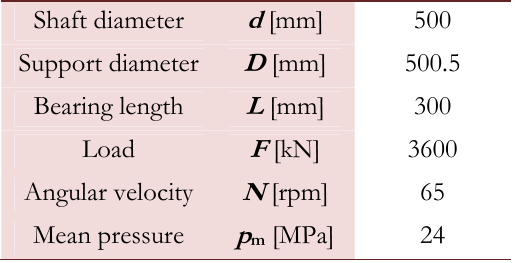
Table 1: Parameters used in numerical